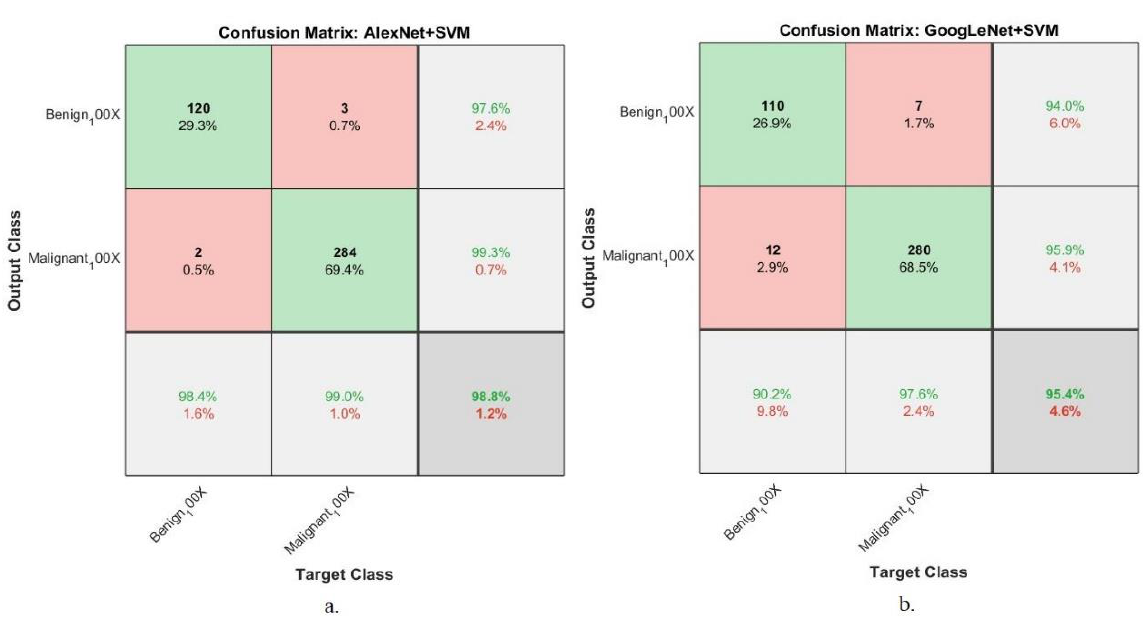
Figure 7. Evaluation of a BC dataset with a magnification of 100× by the confusion matrix produced by ( a ) AlexNet + SVM and ( b ) GoogLeNet + SVM.